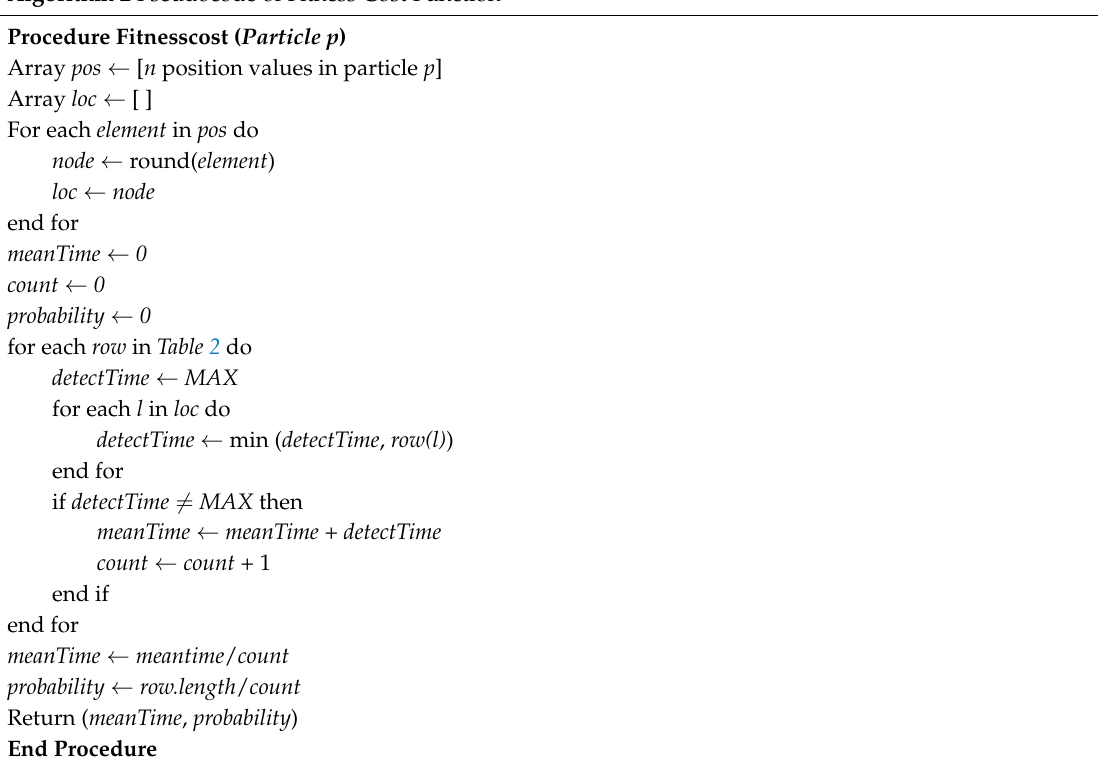
Algorithm 2 Pseudocode of Fitness Cost